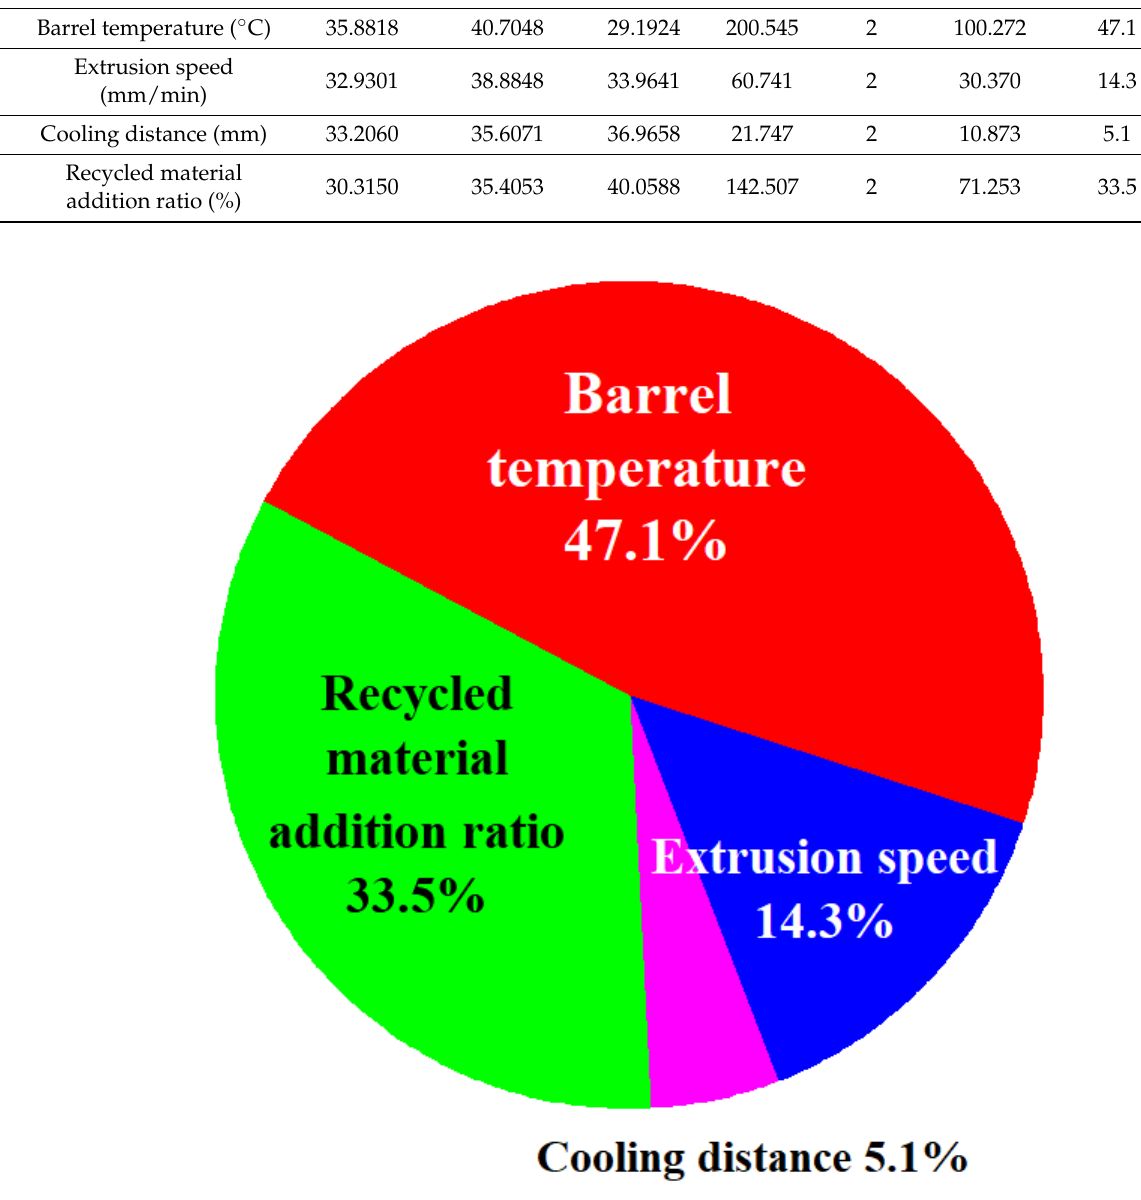
ameter is approximately 1.66 mm. The PLA filament diameters fabricated by the second general process parameters (No. 3 of verification experiments) are 1.63 mm, 1.65 mm, and 1.66 mm, respectively. The average PLA filament diameter is approximately 1.65 mm. The PLA filament diameters fabricated by the third general process parameters (No. 4 of ver- ification experiments) are 1.62 mm, 1.61 mm, and 1.65 mm, respectively. The average PLA filament diameter is approximately 1.63 mm. It should be noted that the results were in good agreement with results from ANOVA optimal level. This shows that the average diameter of the PLA filament fabricated by the optimal process parameters is obviously better than that of the PLA filament fabricated by the general process parameters.